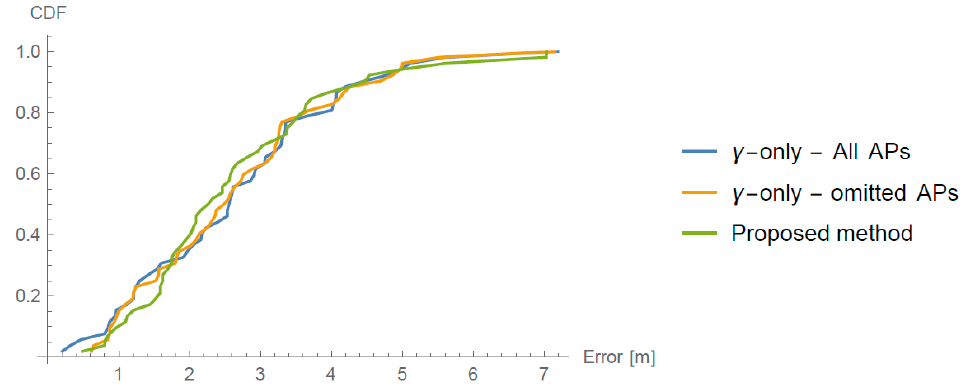
Figure 13. CDFs of the errors of all three discussed methods.